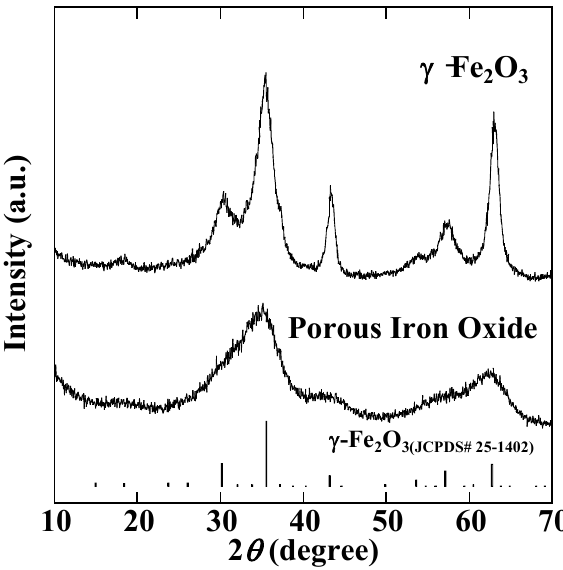
Figure 5. XRD patterns of solid particles obtained by alka- line treatment and of (cid:2) -Fe 2 O 3 particles obtained by heat- ing (cid:2) -FeOOH particles at 523